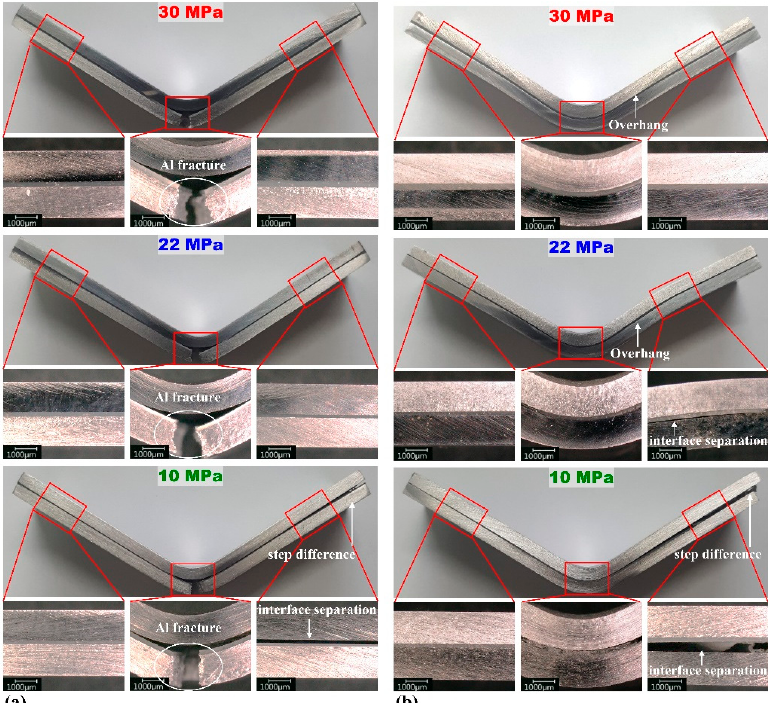
Figure 8. DP590–A356 multi-material after the flexure test: ( a ) steel (upper)–aluminum (lower) and ( b ) steel (lower)–aluminum (upper). The white circle indicates the Al fracture, while the white arrow indicates interface separation or step difference.